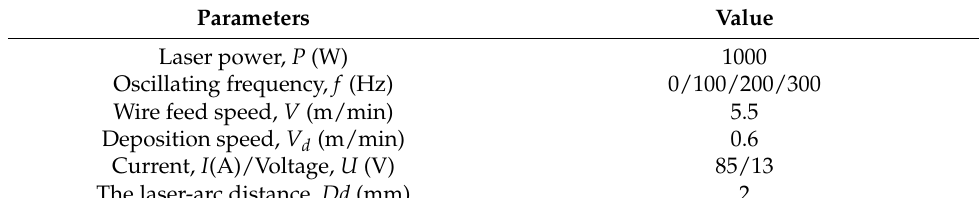
Table 2. Main processing parameters in the additive manufacturing experiment.